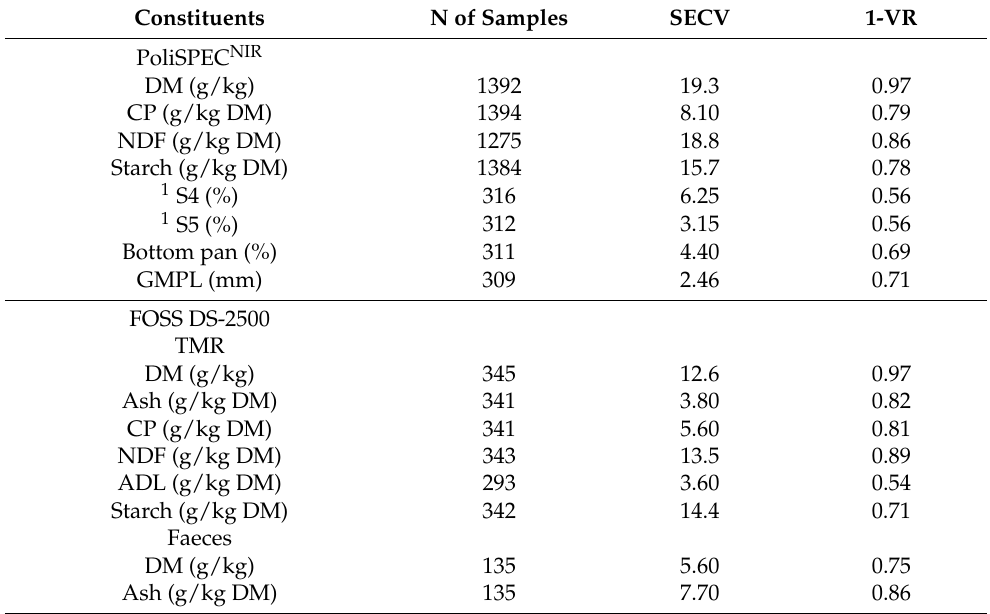
Table 2. Specifications of the PoliSPEC NIR calibration curves developed and used for the calculation of homogeneity index (HI) of the total mixed ration (TMR) and specifications of the FOSS DS-2500 calibration curves used to measure the chemical composition of faeces and the chemical and physical composition of